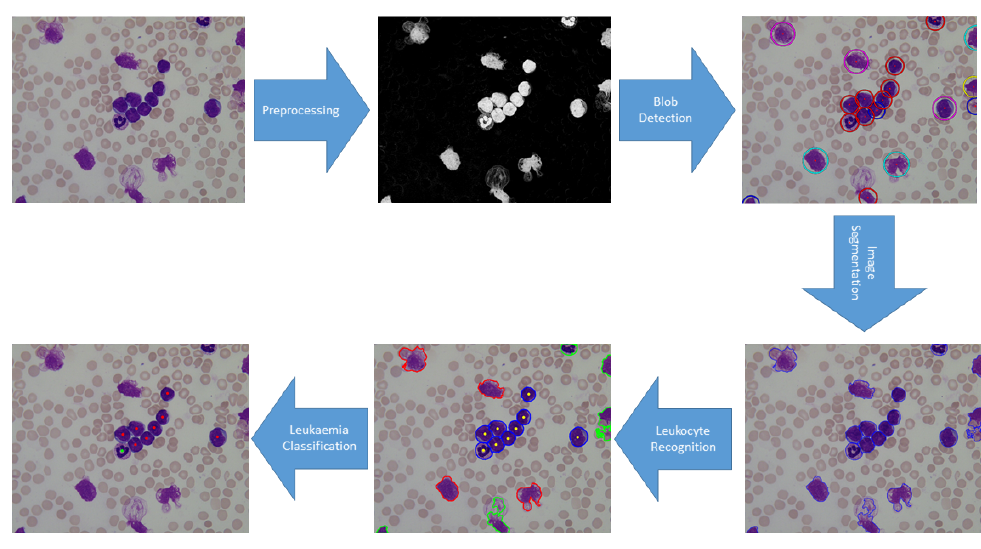
Figure 4. The overall scheme of the proposed